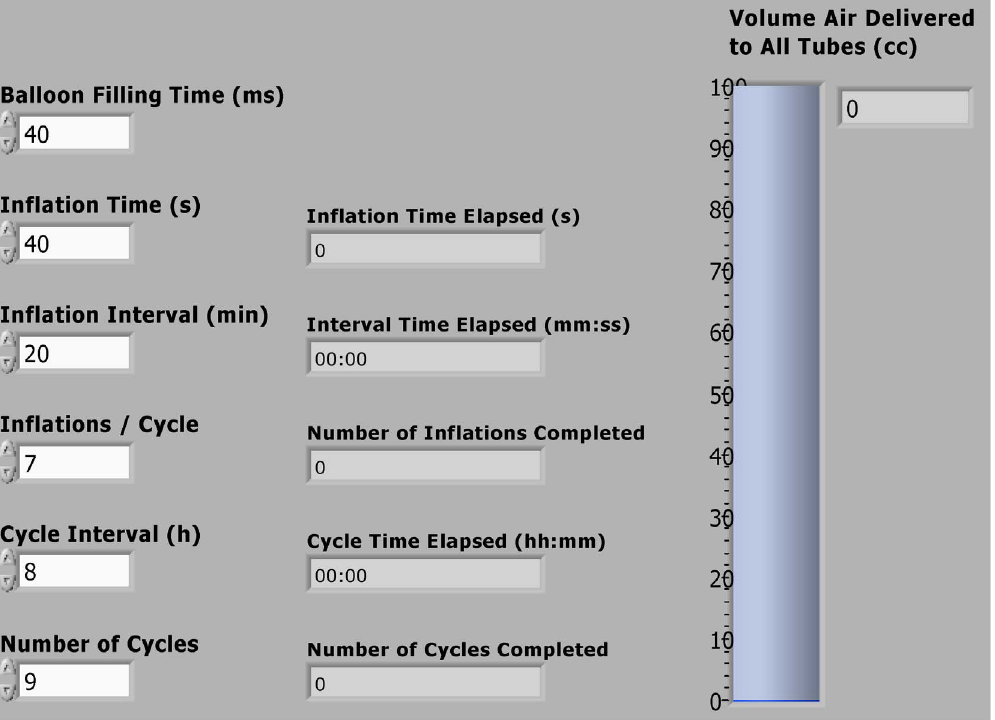
Figure 6. The software user interface (Labview front panel) allows the user to adjust parameters for automated inflation: the catheter pressurization (balloon filling time); the duration that the catheter remains inflated (inflation time); the interval between subsequent, shortly-spaced inflations in a cycle (inflation interval); the number of inflations per cycle (inflations/cycle); the interval between cycles (cycle interval); and the total number of cycles. For each of these sequences, a timer or counter displays the progress of the automated inflation. A bar plot displays the inflation volume, as measured by the flow meter.